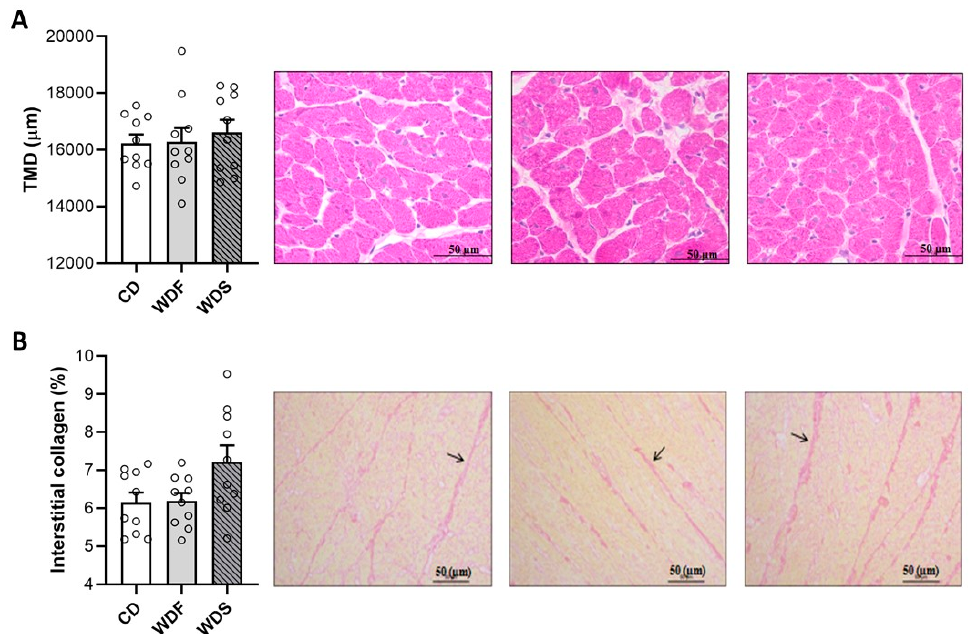
Figure 8. Left ventricle histologic analysis at the 41st week of dietary intervention with Control diet (CD), Western diet fat (WDF), and Western diet sugar (WDS). ( A ) Transverse myocyte diameter (TMD). ( B ) Collagen interstitial fraction (evidenced with arrows). Data are presented as mean ± s.e.m. One-way ANOVA with Tukey post-hoc test (n = 10 rats per group).